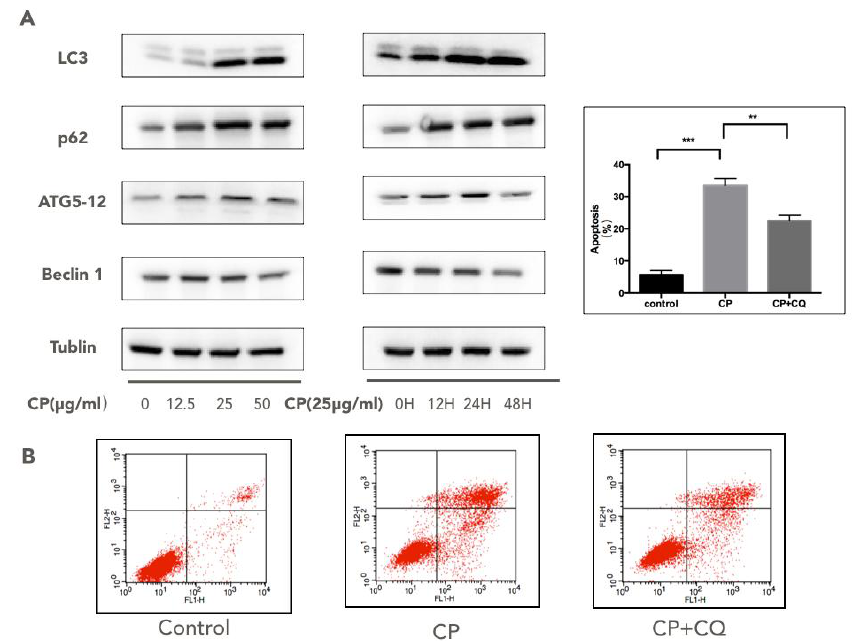
Figure 4. Autophagy was induced in human melanoma cells after Chinese propolis (CP) treatment, which contributed to apoptosis. ( A ) The expressions of the Atg5/Atg12 complex, Beclin1, p62 and LC-3 conversion in A375 cells after CP treatment at different doses (12.5 µ g/mL, 25 µ g/mL, 50 µ g/mL) and times (12 h, 24 h and 48 h) were analyzed by Western blotting ( B ) The apoptosis rate induced by CP was reduced after autophagy was inhibited. A concentration of 2.5 µ M chloroquine (CQ) was applied to 50 µ g/mL CP-treated A375 cells to suppress autophagy. The apoptosis rate was declined significantly after co-treatment with CQ and CP in comparison with the CP-treated group. ** p < 0.005 and *** p < 0.001 for the designated treatment versus the control (vehicle). FL1-H and FL2-H represent the specific fluorescence.